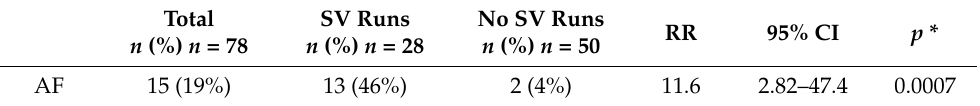
Table 4. Comparison of the incidence of AF in patients with and without SV